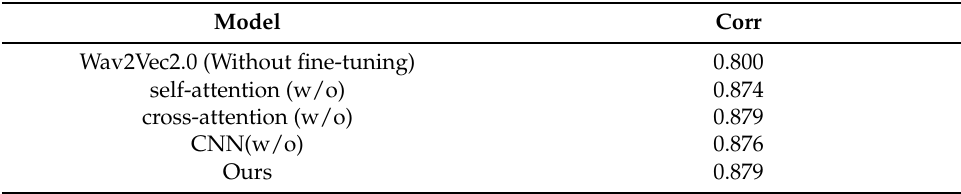
Figure 9. Comparison of different models on Speechocean762 of fluency scores. Table 12. Ablation study on PSCPSF.